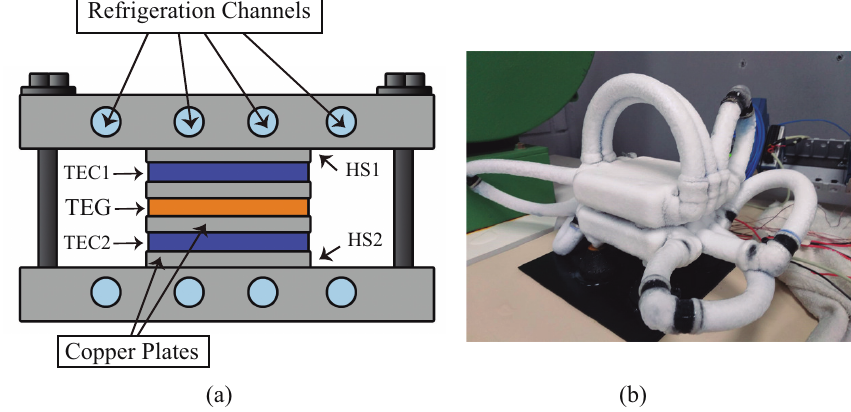
Figure 3. Experimental test rig: ( a ) diagram; ( b )